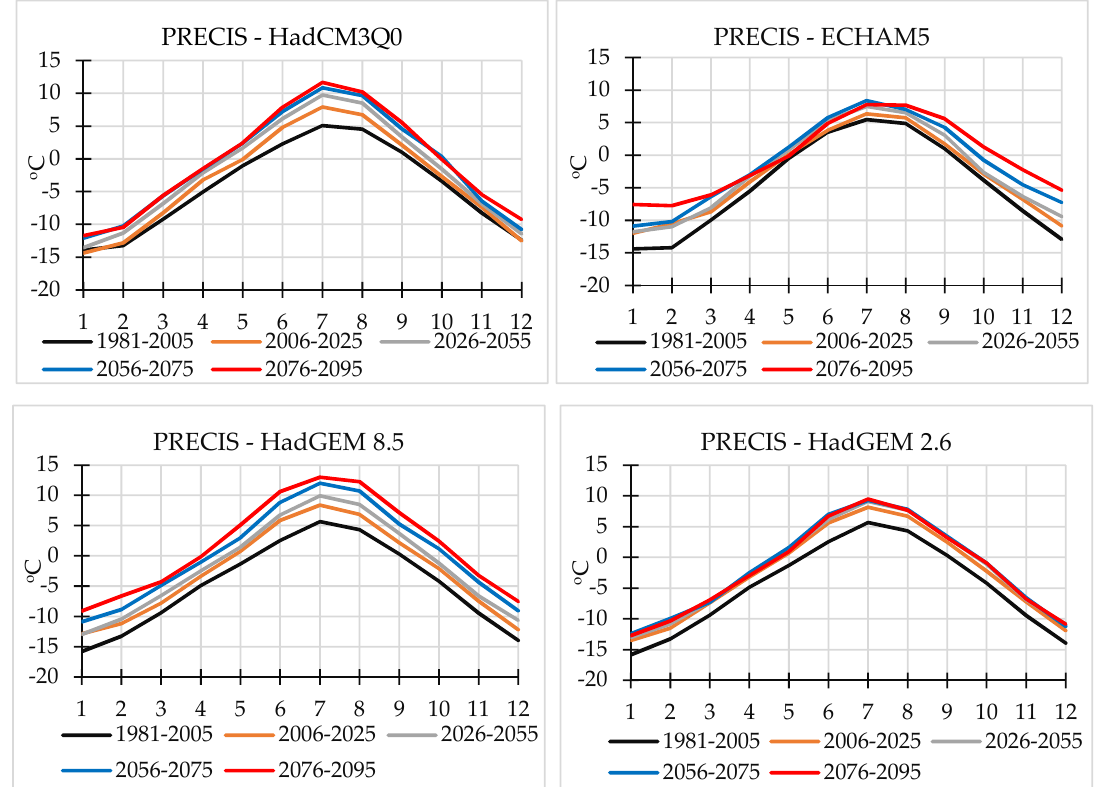
Figure 6. Air temperature scenarios for the study region. Note an increase in air temperature in the first quarter of the century under HadGEM 2.6 scenario and a continuing increase in temperature under HadGEM 8.5 scenario.